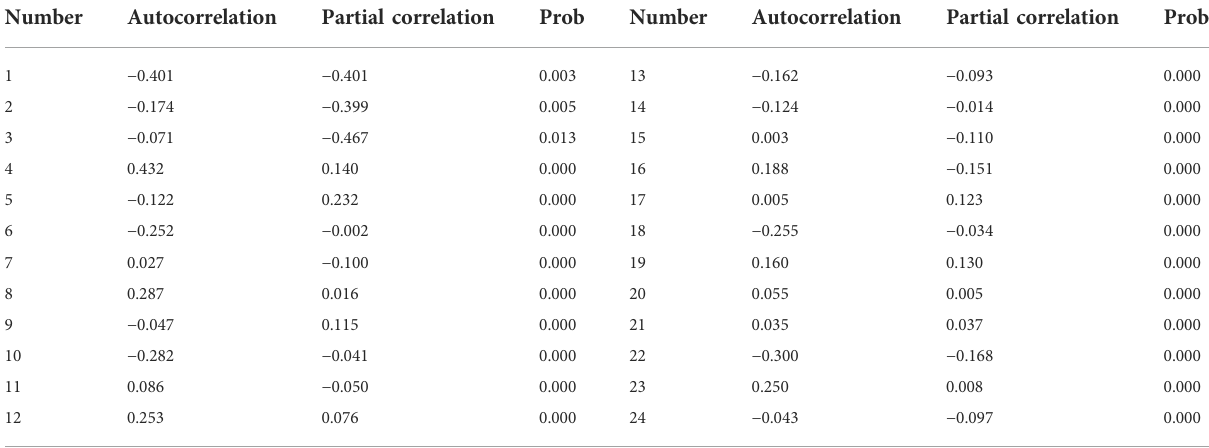
TABLE 4 Autocorrelation and Partial Correlation coef fi cient of the Second-order difference results.